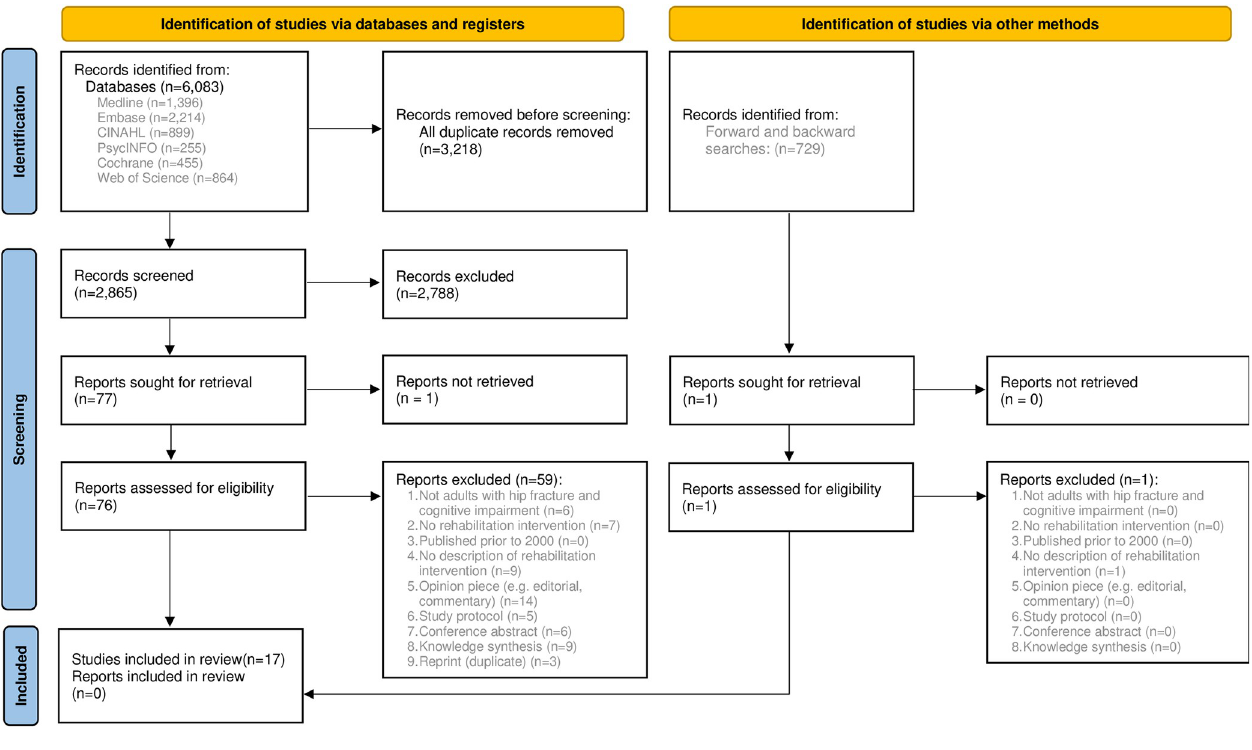
Fig 1. PRISMA 2020 flow diagram of included